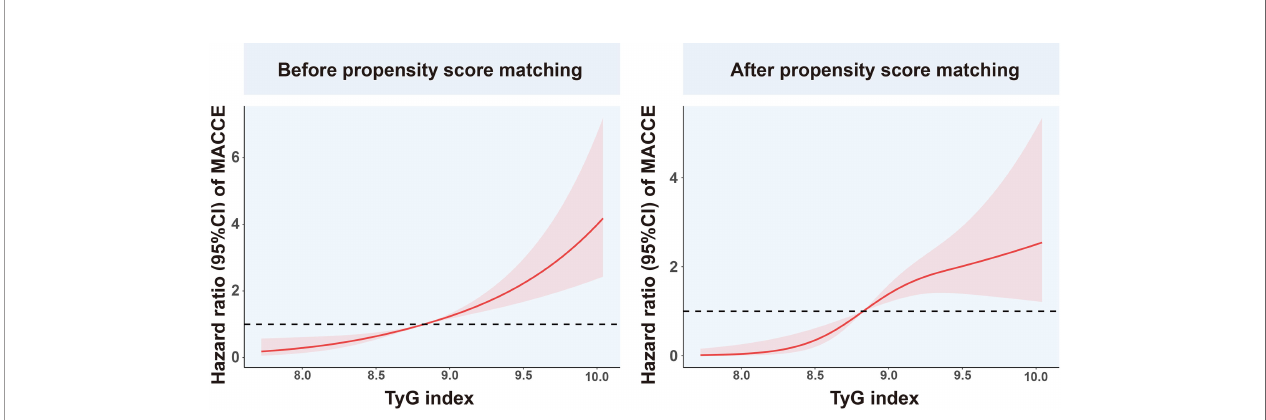
FIGURE 5 | Restricted cubic spline analysis of the association between TyG index and MACCEs. TyG, triglyceride-glucose; MACCEs, major adverse cardiovascular and cerebrovascular